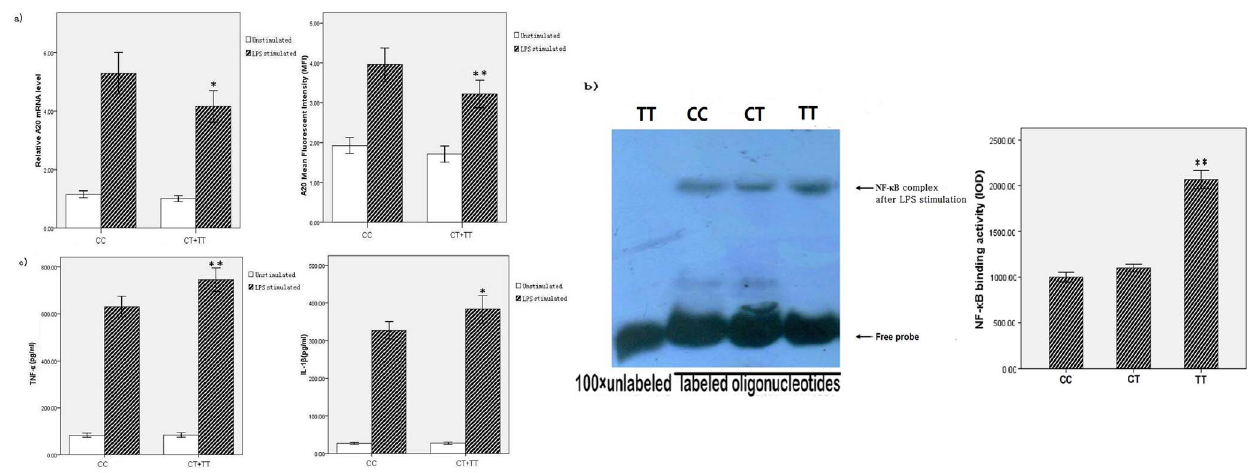
Figure 2. Effect of the rs5029924 polymorphism on in vitro LPS stimulation of whole blood. a ) After LPS stimulation, mRNA and protein expression levels of TNFAIP3 were significantly different between individuals harboring the CC and individuals harboring the CT + TT genotypes ( p =0.012 and 0.007, respectively). b ) NF- k B bound to specific DNA sequences were determined by electrophoretic mobility shift assays on polyacrylamide gels, after LPS stimulation. The IOD of NF- k B complex in individuals harboring the TT was significantly higher than the CC and TT genotype ( p , 0.001), and no significantly difference was recorded between the CC and TT genotype ( p =0.065). c ) The TNF- a and IL-1 b levels in supernatants were significantly different between individuals harboring the CC or the CT + TT genotypes after LPS stimulation ( p =0.001 and p =0.011, respectively). * p , 0.05, ** p , 0.01 compared with the CC genotype.